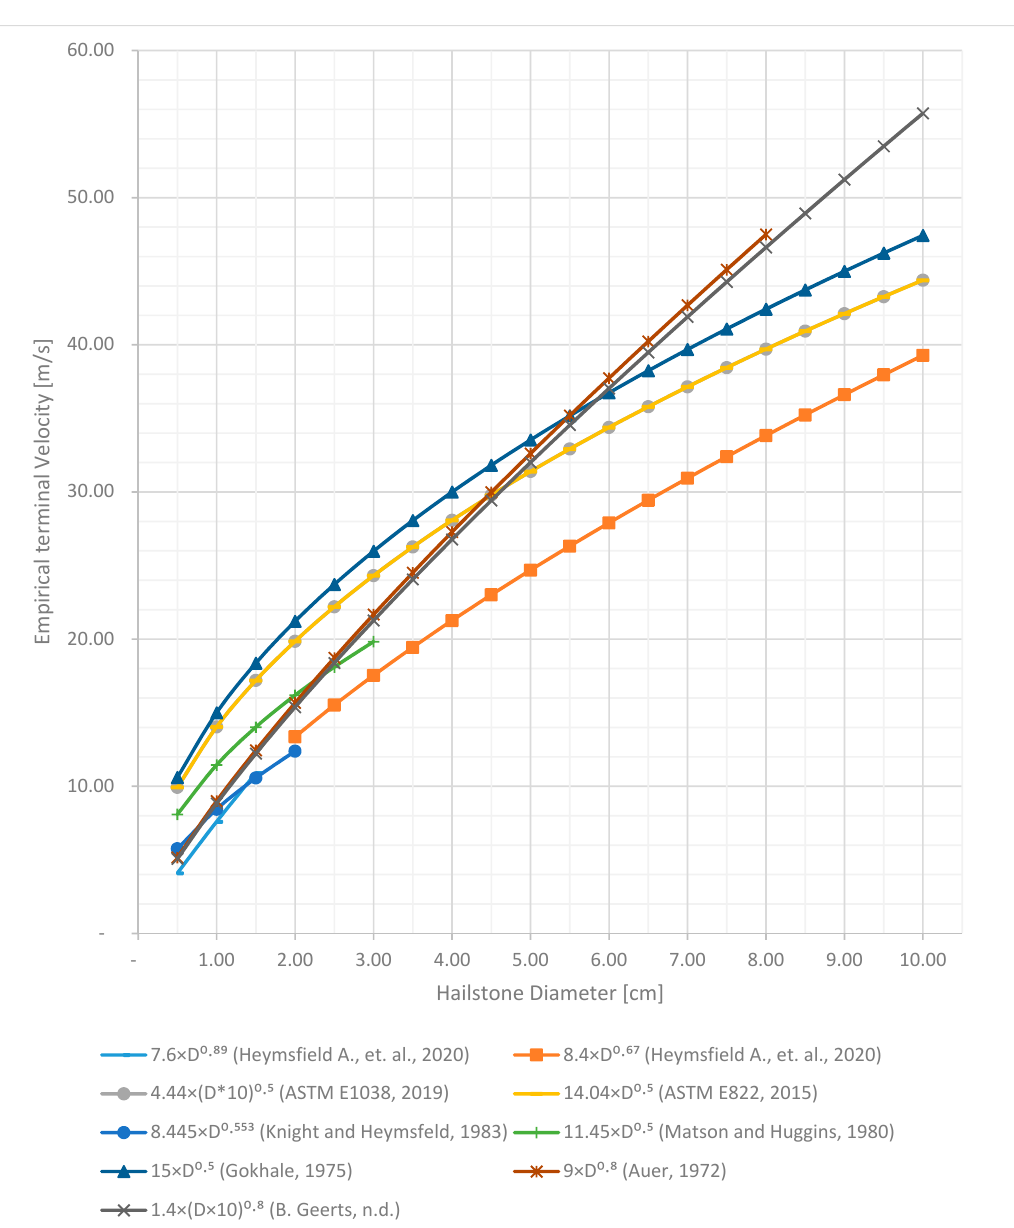
Figure 3. Terminal velocity of hailstones for different empirical models.